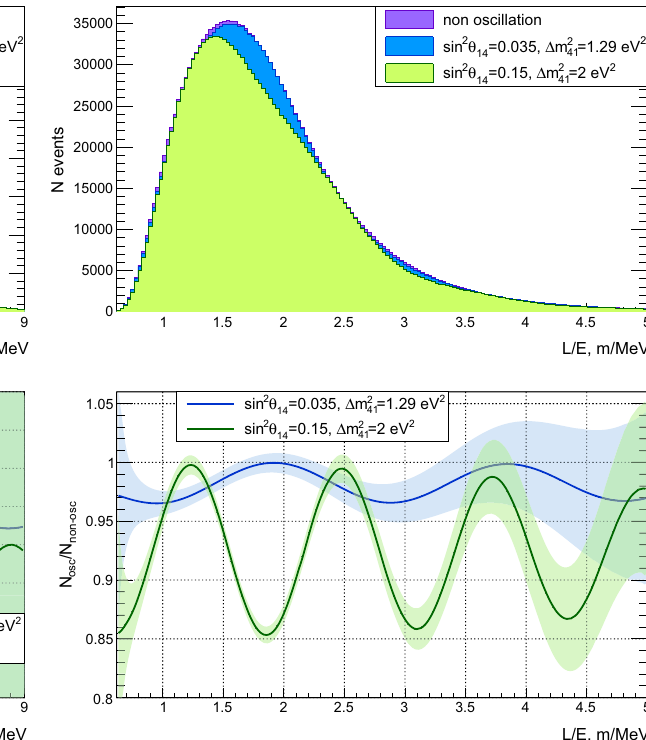
ile neutrino [29]. The bottom left panel corresponds to the appropriated oscillation curves as a function of L / E variable (the right panel is